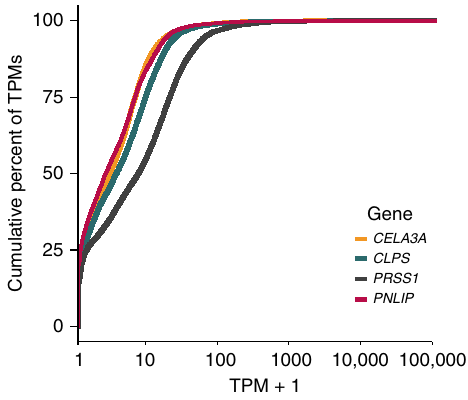
Fig. 2 A cumulative distribution plot of 11,366 non-pancreas RNA-seq samples and their cumulative TPM expression of four pancreas genes. The right shift in PRSS1 is consistent with it having the highest